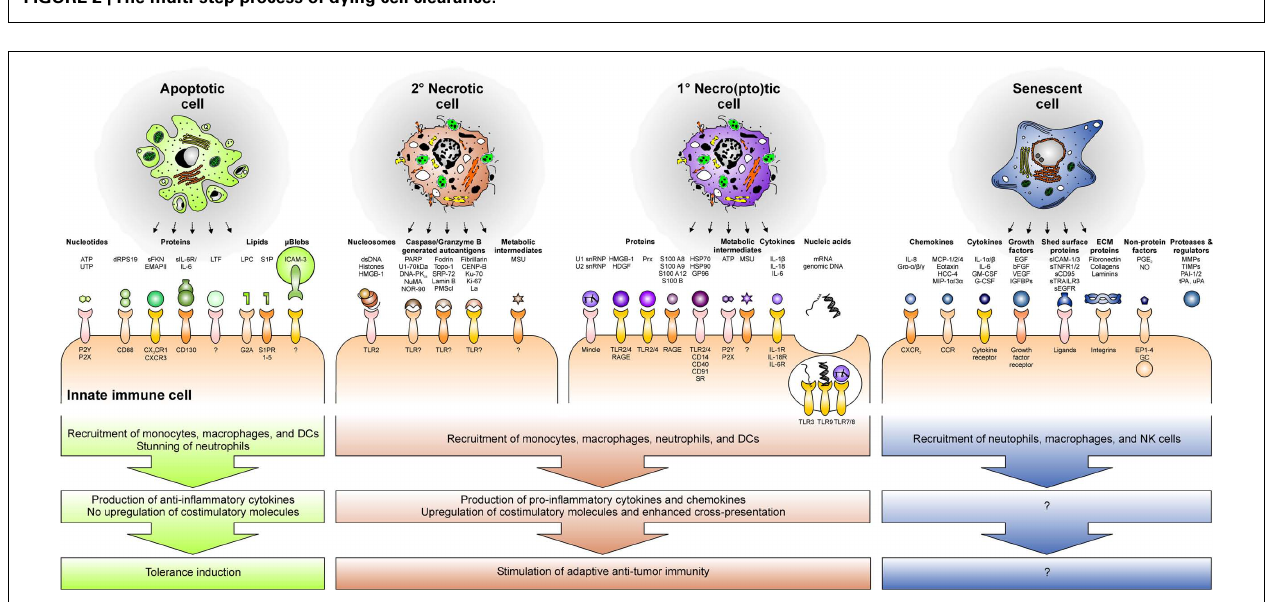
FIGURE 2 |The multi-step process of dying cell clearance.